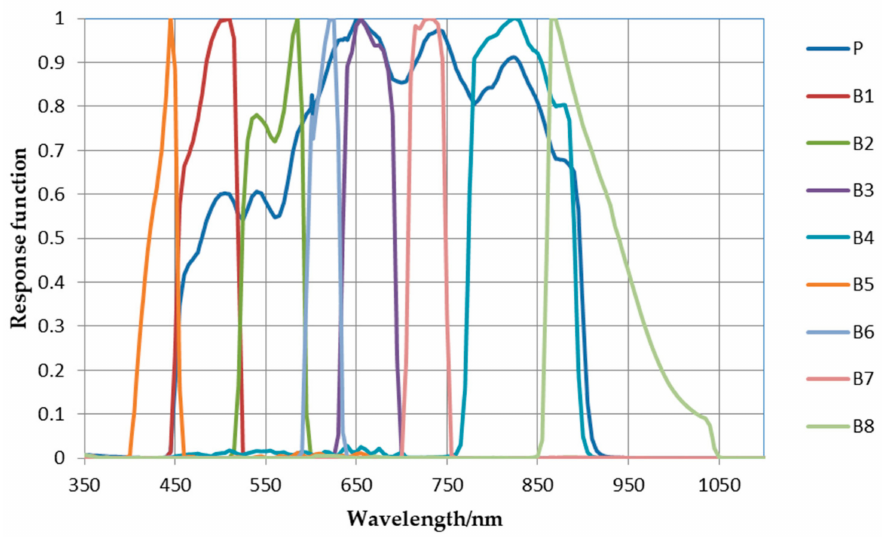
Figure 1. Spectral response function of GFDM satellite. Table 2. Settings of SMAC